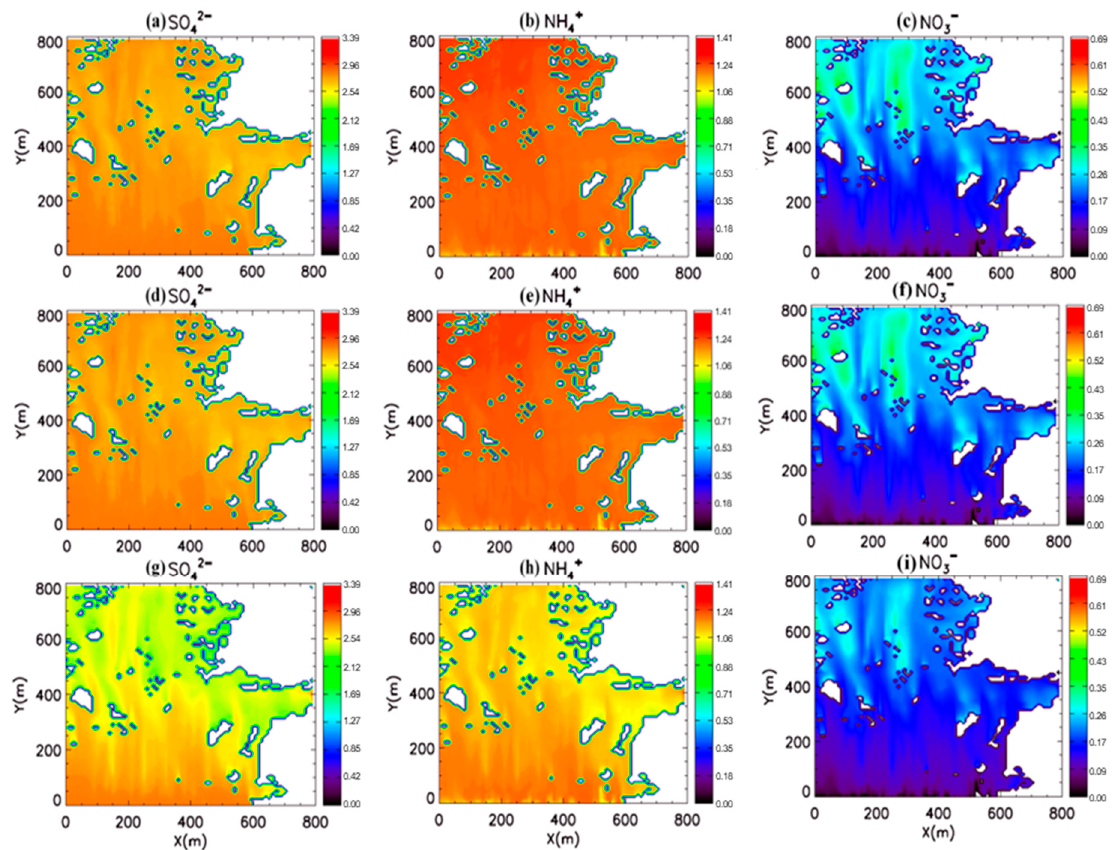
Figure 7. Surface concentrations of secondary inorganic aerosol with and without washout processes in Eunpyeong-Gu, Seoul, Korea. Figures in the upper panel display surface concentrations of ( a ) SO 42 − , ( b ) NH 4+ , and ( c ) NO 3 − without washout processes. Figures in the middle and lower panels indicate the surface concentrations of SO 42 − , NH 4+ , and NO 3 − with washout processes using the wet scavenging coefficients (WSCs) by Feng [35,36] (( d ), ( e ), and ( f ), respectively) and using the optimal estimated WSCs in this study (( g ), ( h ), and ( i ), respectively). Units are µm − 3 .